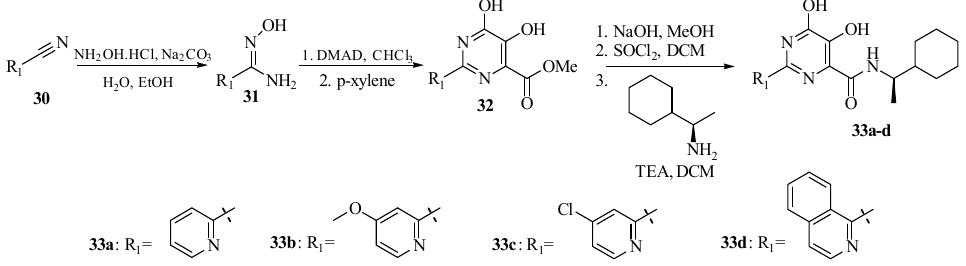
Scheme 8. Synthesis of nucleocapsid inhibitors as anti-HIV/AIDS